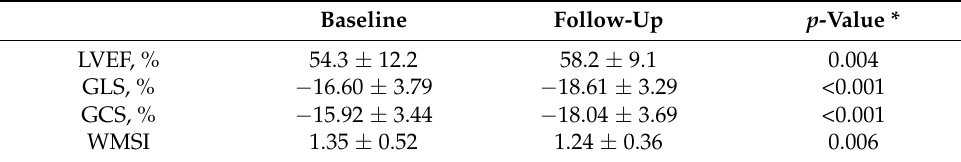
Table 3. Changes in echocardiographic parameters from baseline to follow-up.